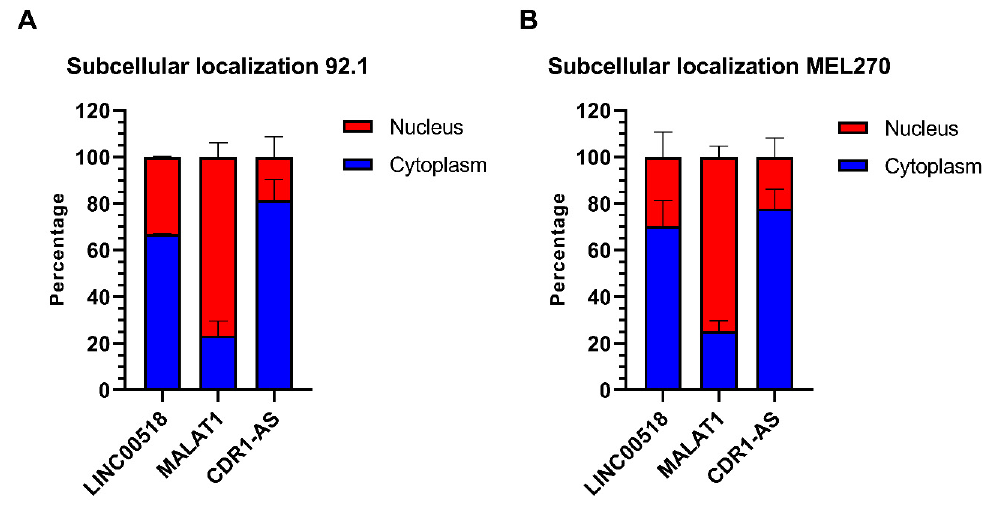
Figure 6. Subcellular localization of LINC00518 . Expression analysis in ( A ) 92.1 and ( B ) MEL270 cells. MALAT1 and CDR1-AS were used as markers of nuclear and cytoplasmic fractions, respectively. Data are shown as percentages. Analysis was performed in three in vitro replicates.